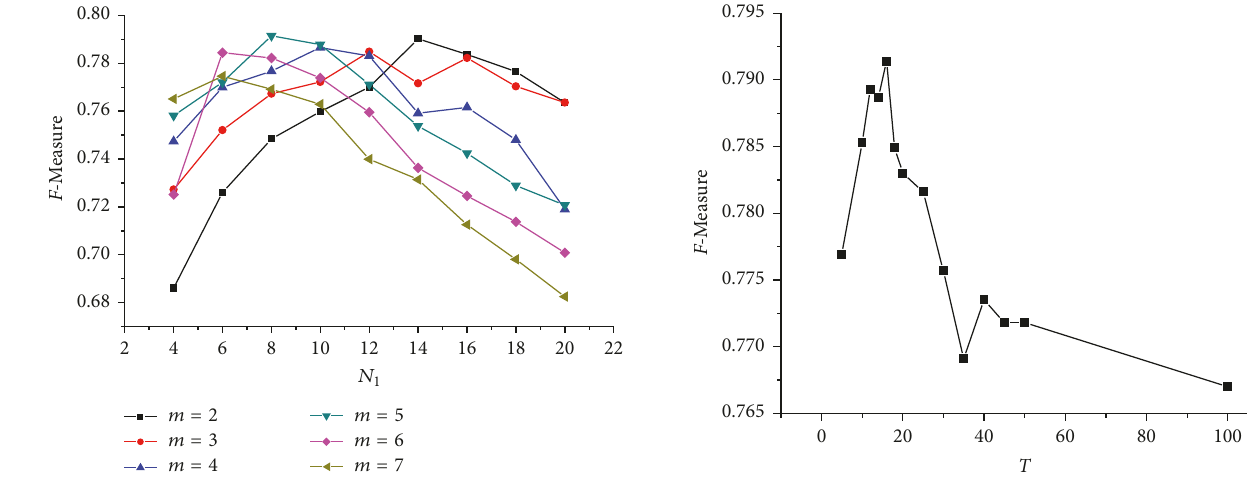
Figure 2: Performance with different 𝑁 1 and 𝑚 . Figure 3: Performance with different 𝑇 value.